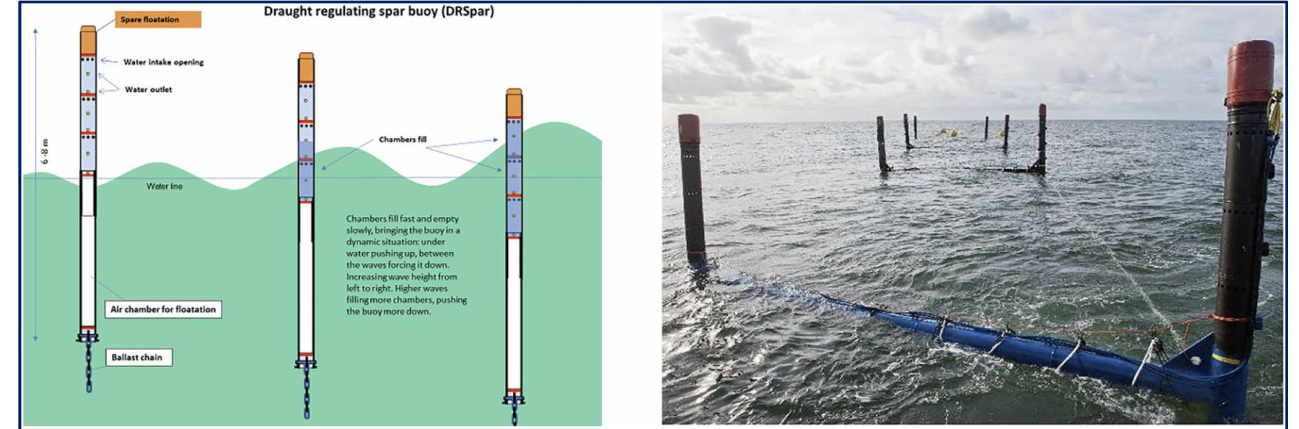
Figure 7. H Frame with wave adaptive spar buoy system. Reproduced with permission [15].